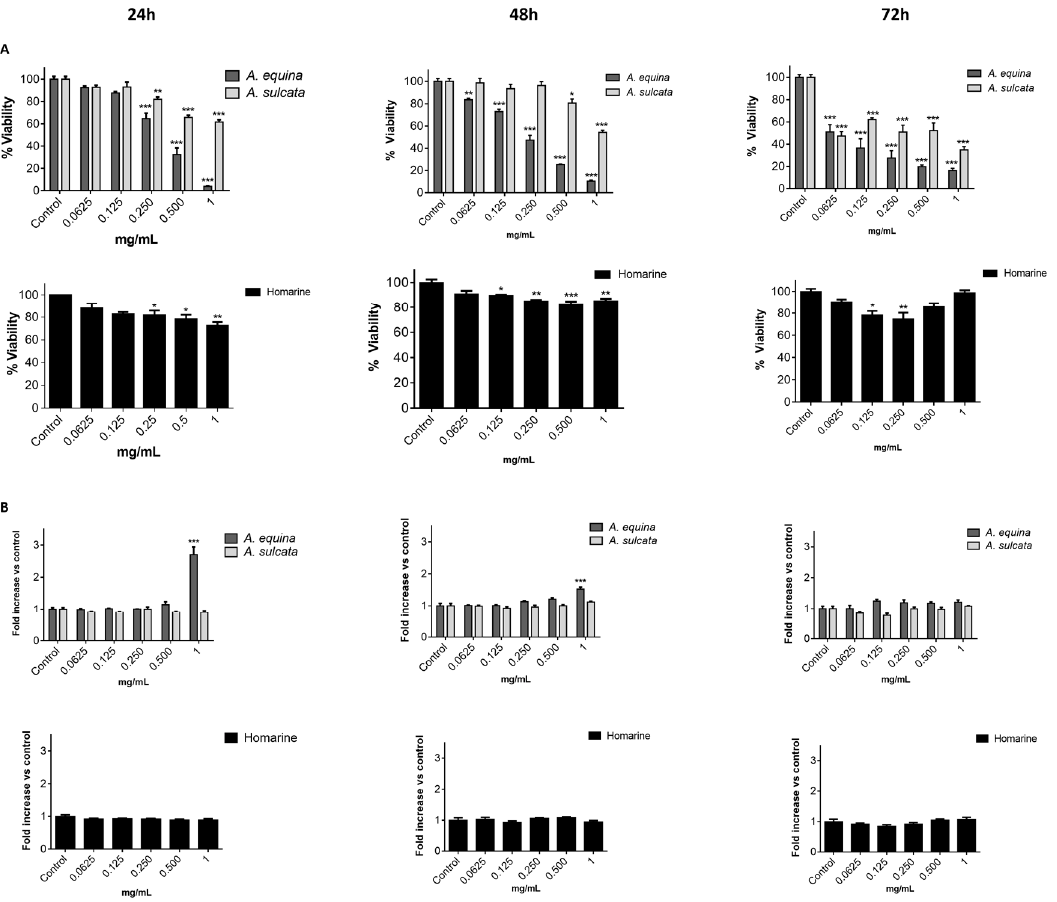
Figure 6. ( A ) Viability of AGS treated with aqueous extracts of A. equina and A. sulcata or homarine for 24, 48, and 72 h; ( B ) Evaluation of membrane integrity in AGS cells. After 24, 48, or 72 h of exposure with the extracts and homarine, LDH activity was quantified. Results are presented as mean ± standard error of the mean of three independent experiments performed in triplicates. Statistical significance: * p < 0.05, ** p < 0.01, *** p < 0.001.